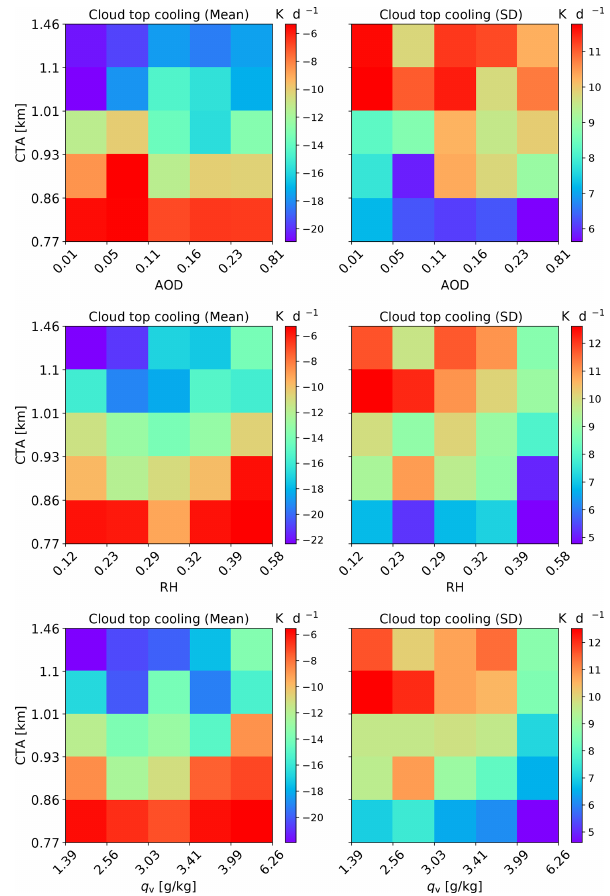
Figure 9. Histograms of the mean and the standard deviation (SD) of the minimum LW cooling at the cloud layer as functions of cloud top altitude (CTA) and AOD, CTA, and RH (between cloud top and 7km) and CTA and q v (between cloud top and 7km). Both periods (JJA and SO) and both aerosol cases (smoke and non-smoke) were used. RH and q v values are derived from variables in the CloudSat ECMWF-AUX